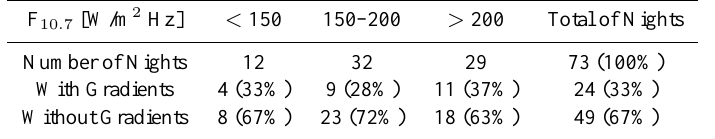
Table 2. Number of nights analyzed with/without thermospheric zonal temperature gradients for three solar flux levels